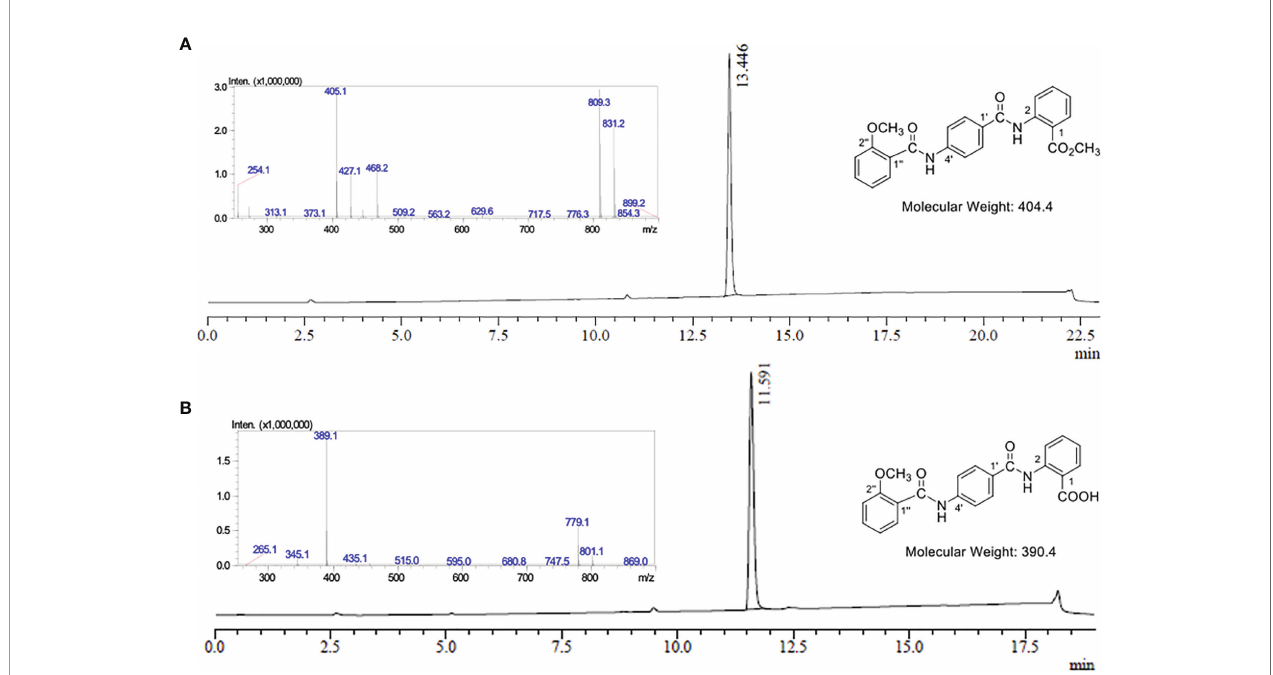
FIGURE 2 | LC-MS analysis of EG1 methyl ester 7 and EG1. (A) UV chromatogram from the LC-MS of EG1 methyl ester 7 at l = 254 nm. LC-MS conditions : Phenomenex Prodigy column (C – 18, 5 m m, 3.00 × 250 mm) at 0.5 mL/min and heated to 40°C. 10% to 100% B over 12.5 min, then 100% B for 6.5 min, 100% to 10% B over 1 min, then 10% B for 3 min. The solvent system for LC purposes was a mixture of A (0.1% formic acid in H 2 O) and B (0.1% formic acid in CH 3 CN). Insert: Mass spectrum in positive ionisation mode at 13.45 mins; MS m/z (ESI+): 405 ([M + H] + , 100%), 427 ([M + Na] + , 34), 809 ([2M + H] + , 93), 831 ([2M + Na] + , 72). (B) UV chromatogram from the LC-MS of EG1 at l = 254 nm. LC-MS conditions : Phenomenex Prodigy column (C – 18, 5 m m, 3.00 × 250 mm) at 0.5 mL/min and heated to 40°C. 10% to 100% B over 12.5 min, then 100% B for 2.5 min, 100% to 10% B over 1 min, then 10% B for 3 min. The solvent system for LC purposes was a mixture of A (0.1% formic acid in H 2 O) and B (0.1% formic acid in CH 3 CN). Insert : Mass spectrum in negative ionisation mode at 11.59 mins; MS m/z (ESI – ): 389 ([M – H] - , 100%), 779 ([2M – H] - ,